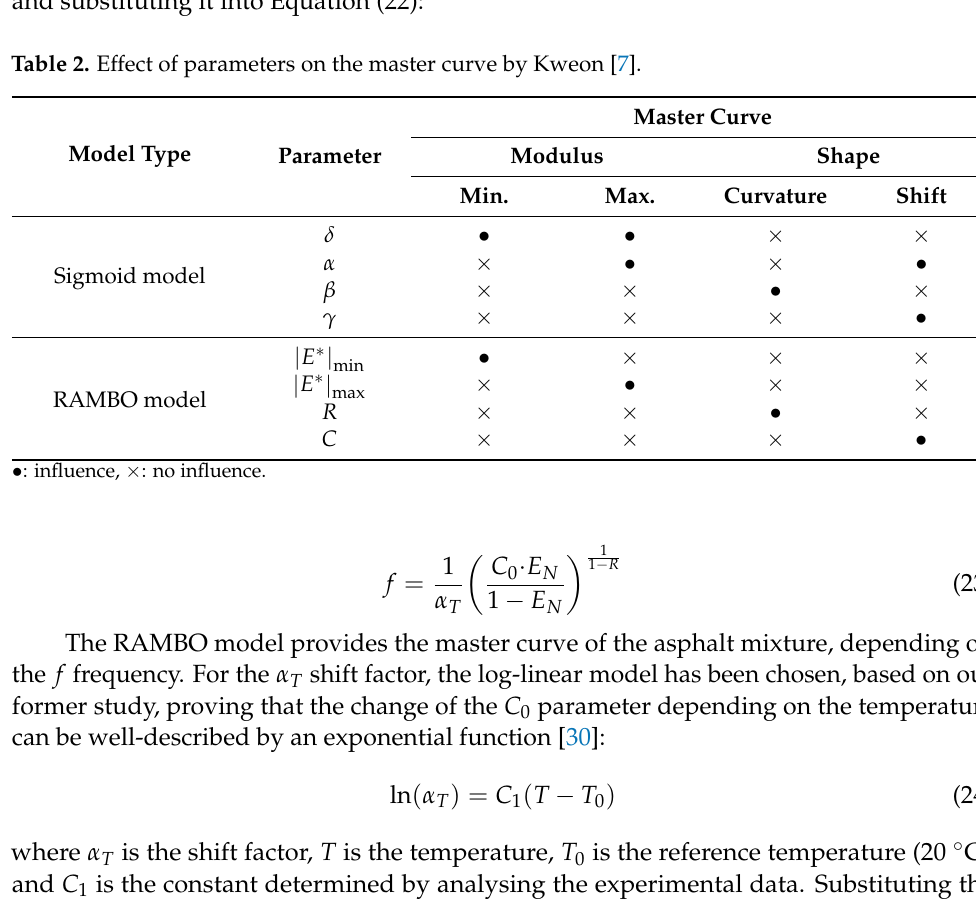
Table 2. Effect of parameters on the master curve by Kweon [7]. Model Type Parameter